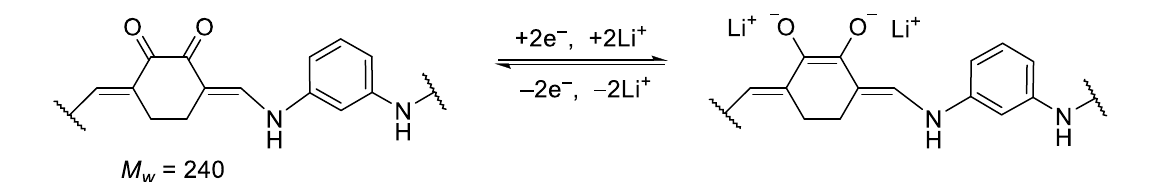
Figure 7. Proposed redox reaction of 4ae material during charge/discharge inside Li-battery.